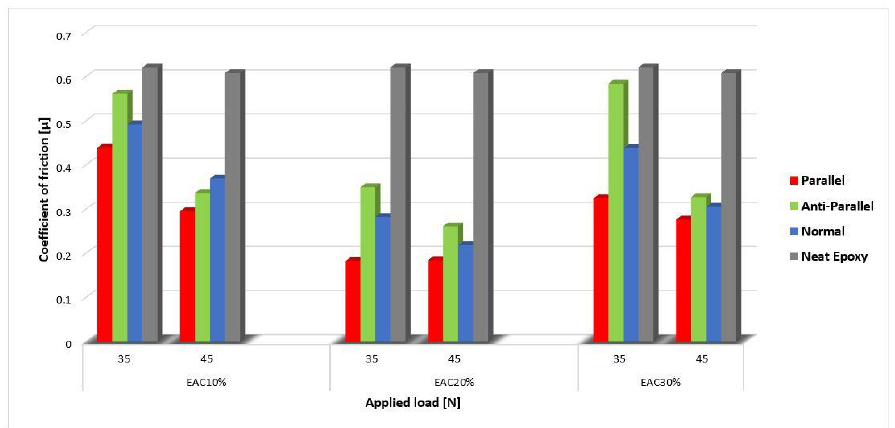
Figure 6. Coefficient of friction of EACs and neat epoxy, per two applied loads, after 800 m of sliding distance.